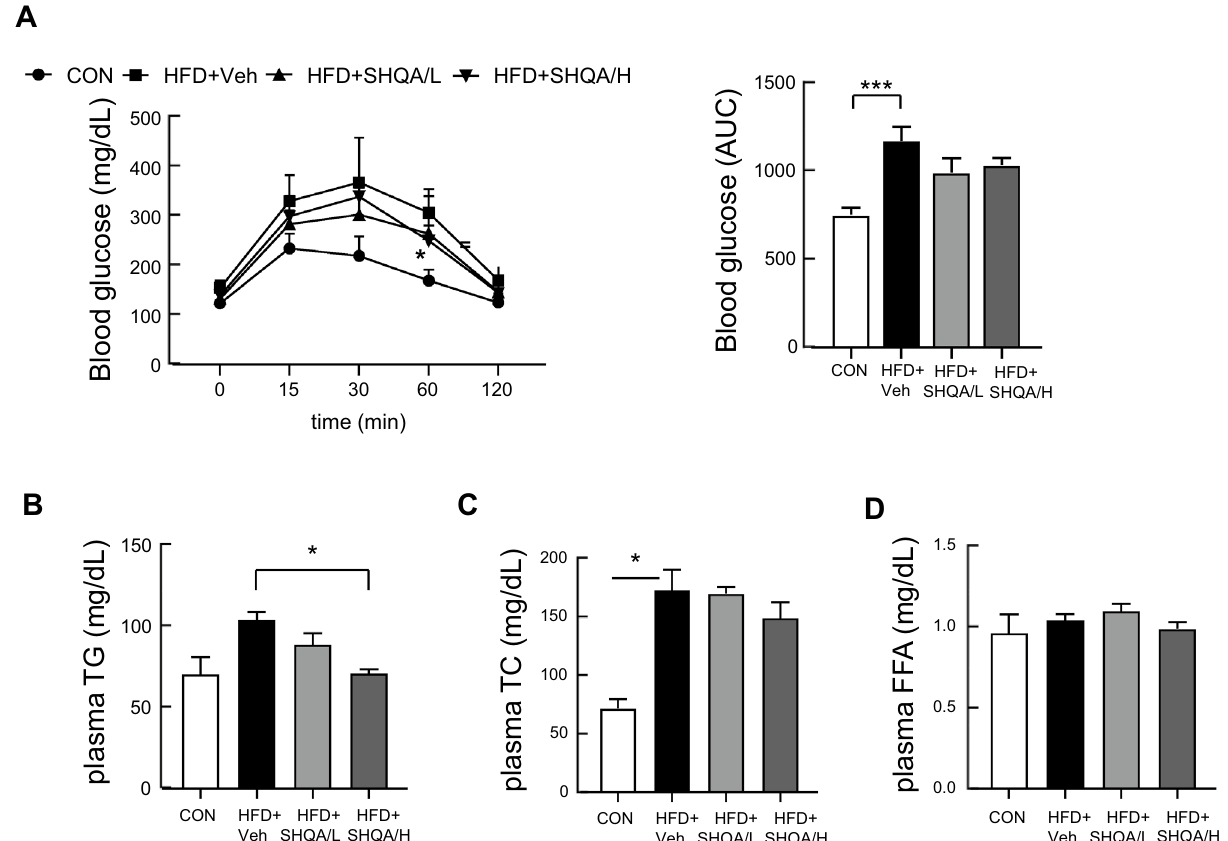
Figure 4. Hypothalamic injection of SHQA improves the metabolic profile in HFD-fed mice. Standard C57BL/6 mice (4 weeks old) were fed a chow diet (CON) or a HFD with the hypothalamic injection of PBS (CON or HFD + Veh, three times a week), a low dose (HFD + SHQA/L, 20 ng/µl, three times a week) or a high dose of SHQA (HFD + SHQA/H, 100 ng/µl, three times a week) for 12 weeks. The blood of these mice was collected for measuring metabolic profiles. ( A ) A glucose tolerance test was performed using 12 wk-old mice fed a chow diet or HFD with or without SHQA injection. The area under the curve was calculated using the values from ( A ). ( B ) Total triglycerides, ( C ) Total cholesterols, and ( D ) Free fatty acids in the blood were determined using commercially available kits. Data are expressed as mean ± S.E.M. (n = 6–7). Statistical differences between CON, HFD + Veh, HFD + SHQA/L (SHQA, 20 ng/µl), and HFD + SHQA/H (SHQA, 100 ng/µl) were determined using one-way ANOVA followed by the Tukey’s post hoc test: * p < 0.05, *** p <